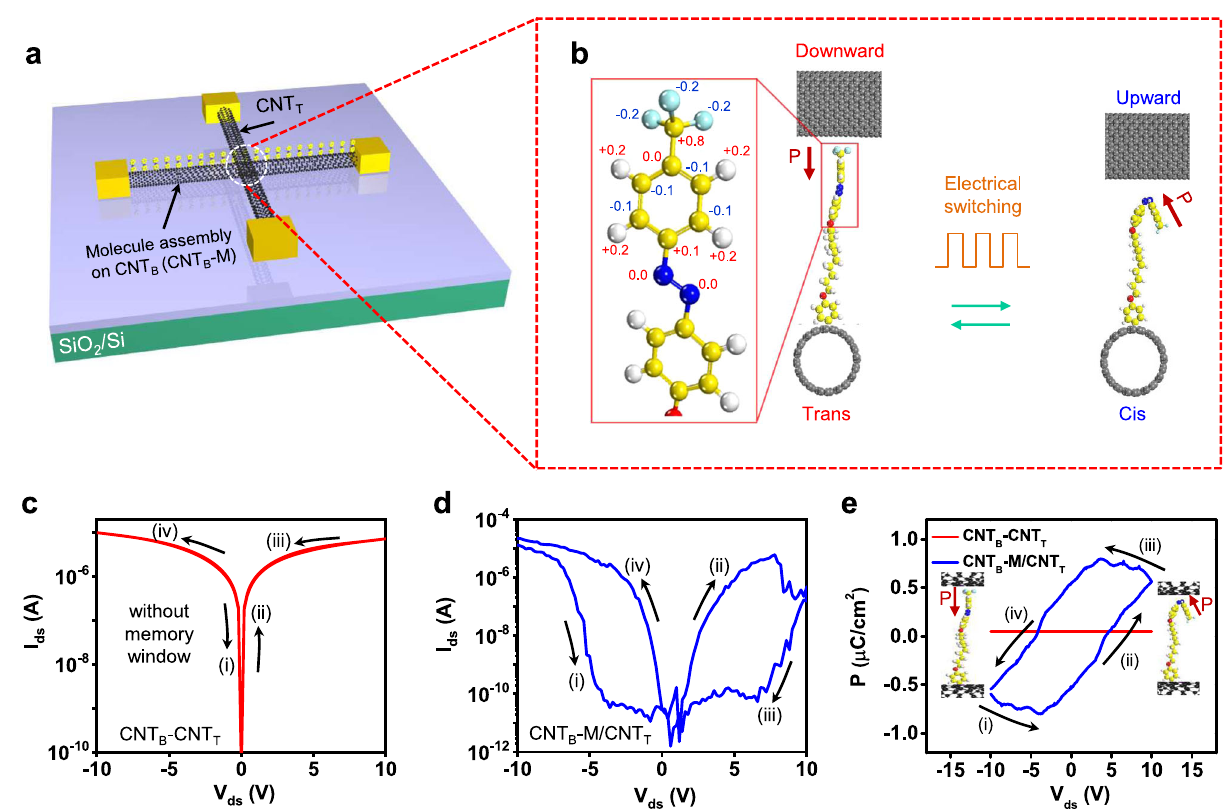
Fig. 2 | Device structure and ferroelectric characteristics of the CNT B -M/CNT T vdWI. a Three-dimensional view of the CNT B -M/CNT T vdWI. The layers (from bottom to top) are CNT B , molecule (M), and CNT T . b DFT simulation model of the molecule polarization change based on trans and cis isomers in CNT B -M/CNT T vdWI according to electrical switching. c Output characteristic ( I ds -V ds ) curves of CNT B -CNT T device (without molecule assembly). Forward (i, ii) and reverse (iii, iv) scans indicating no memory windows at V ds sweep ranges=±10V (negligible